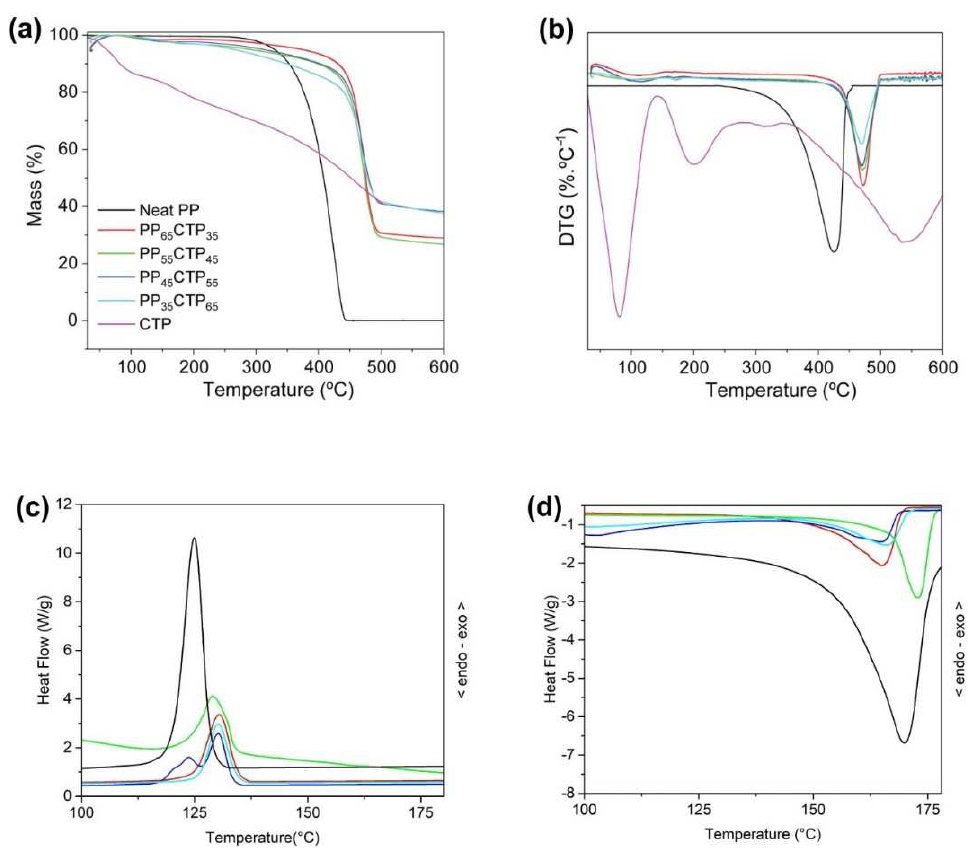
Figure 3. ( a ) Thermogravimetric (TG) and ( b ) derivative TG (DTG) curves, and DSC curves for ( c ) first and ( d ) second heatings for the PP-CTP composites and their single phases. Table 1. Crystallization (Tc) and melting (Tm) temperatures, heat of fusion ( ∆ Hf) and degree of crystallinity (Xc) for the CTP-PP